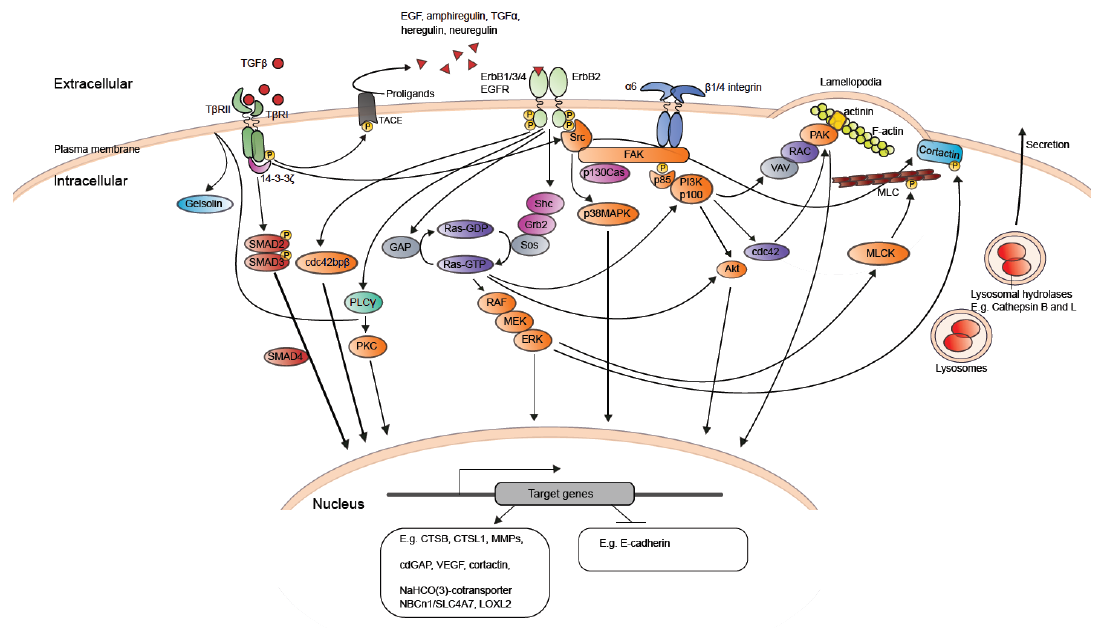
Figure 1. Simplified presentation of invasion and migration inducing